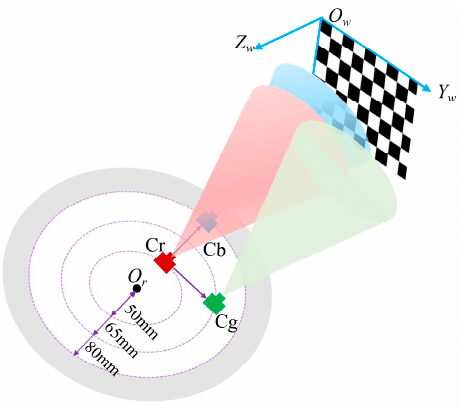
Figure 5. The rotation diagram of the simulated camera placed at positions Cr, Cg and Cb.